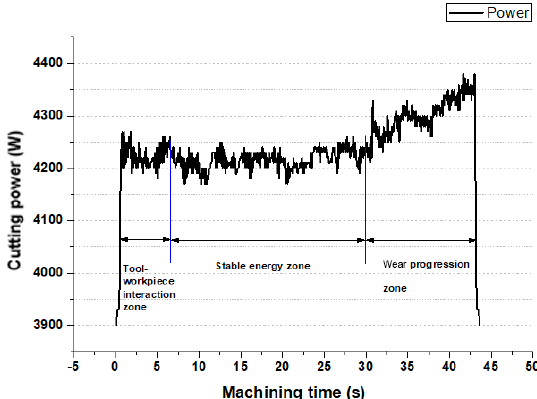
Figure 4. The experimental setup used for turning operation and the SCE measurement. Figure 5. Energy zones during machining titanium (Ti-6Al-4V) al- loy at speed, V = 200mmin − 1 , feed rate, f = 0 . 12mm per rev and depth of cut, d = 1mm.